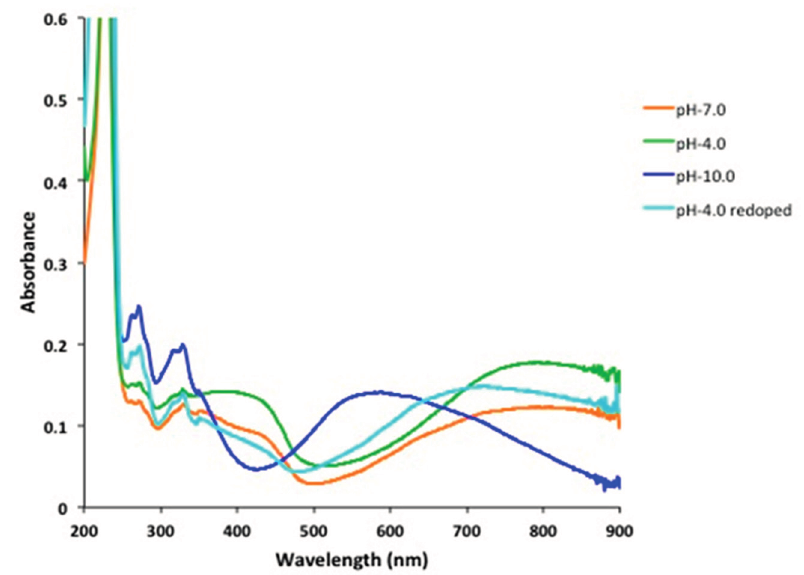
Figure 6. Absorbance responses of PANI-Nap at different pH.